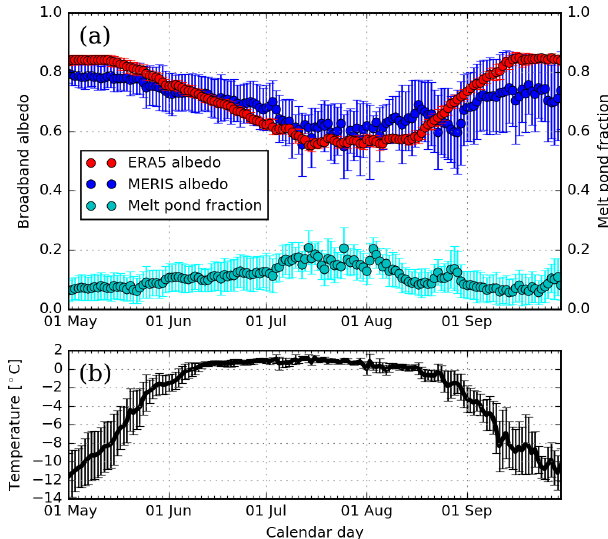
Figure 4. (a) Grid cell broadband albedo from ERA5 (red) and MERIS (blue), as well as MERIS melt pond fraction (cyan), at grid cells of 100% sea-ice concentration according to ERA5 and at dis- tances more than 50km from coastlines. (b) Respective 2m temper- ature from ERA5. Points and the black line show the values between 2003 and 2011, which are averaged spatially and yearly. Error bars represent their standard